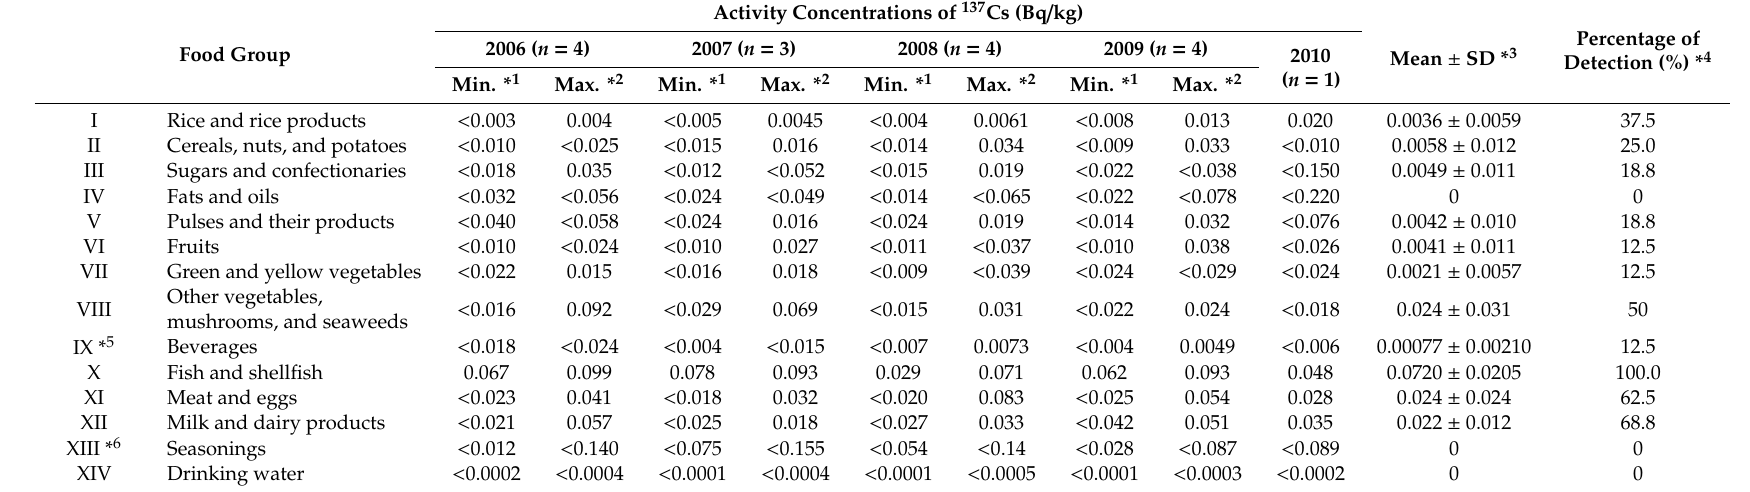
Table 1. Activity concentrations of 137 Cs in Japanese total diet study samples from 2006 to